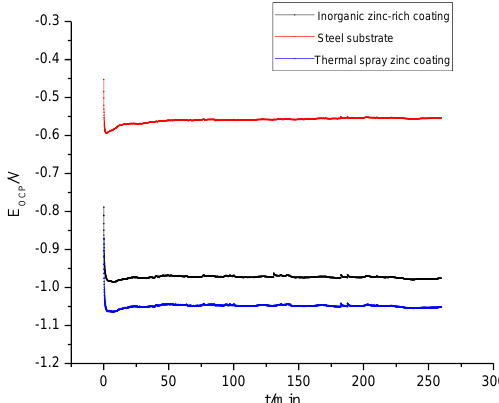
Figure 5. The open circuit potential-time curves of the steel substrate and two zinc coatings.